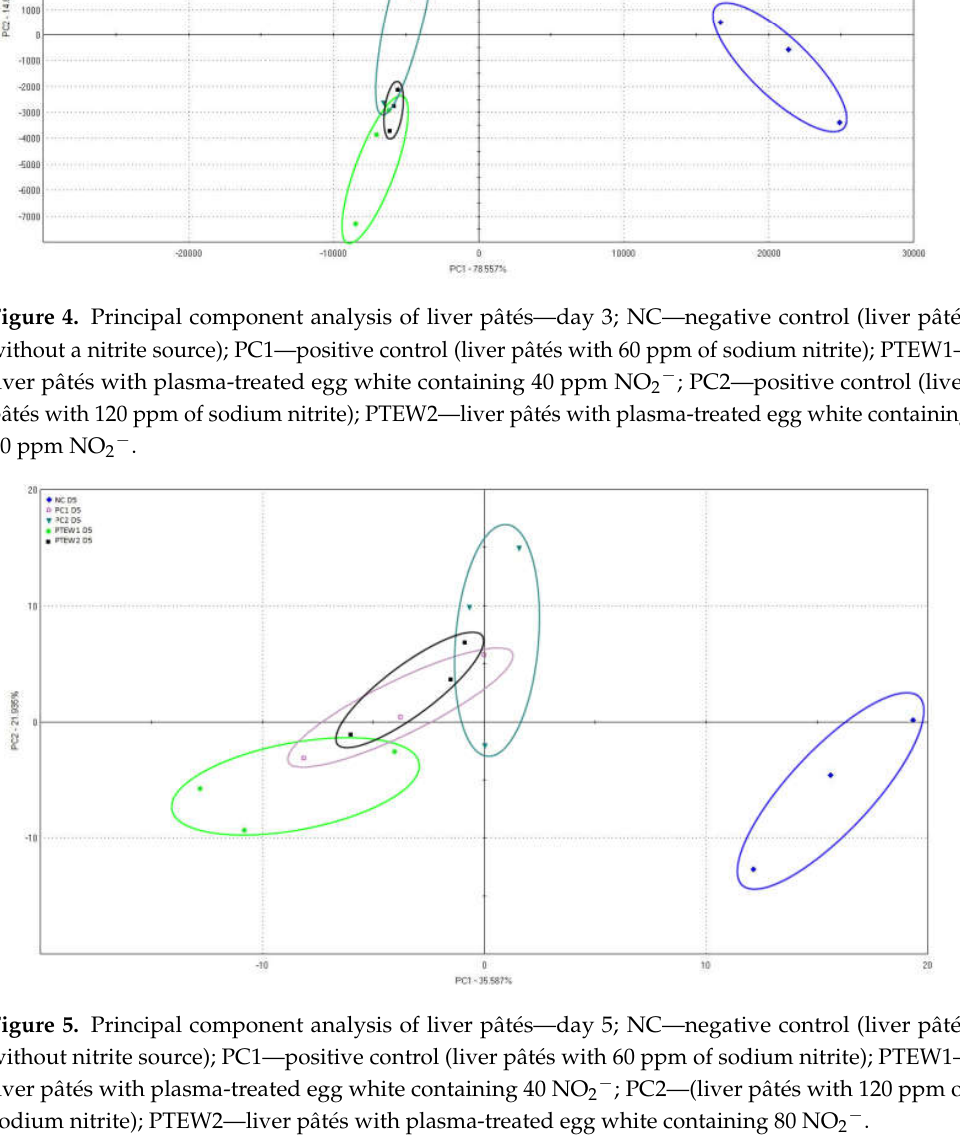
Figure 5. Principal component analysis of liver pâtés—day 5; NC—negative control (liver pâtés without nitrite source); PC1—positive control (liver pâtés with 60 ppm of sodium nitrite); PTEW1— liver pâtés with plasma-treated egg white containing 40 NO 2− ; PC2—(liver pâtés with 120 ppm of sodium nitrite); PTEW2—liver pâtés with plasma-treated egg white containing 80 NO 2− .